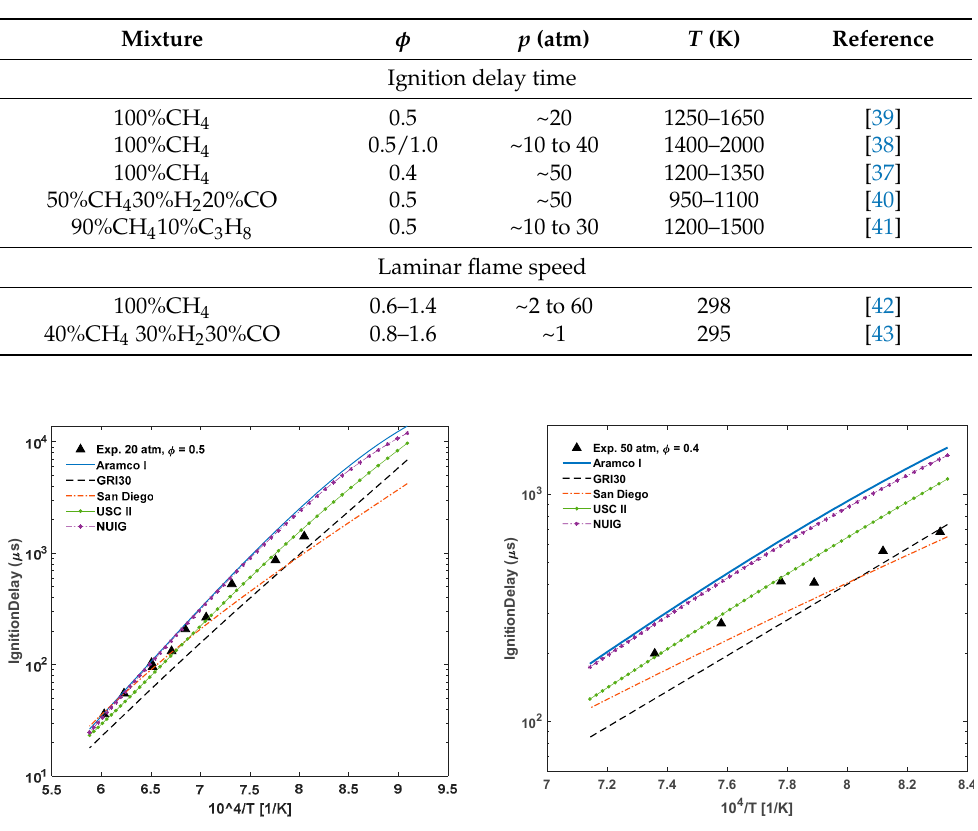
Figure 1. Comparison of methane ignition delay time for different mechanisms with the experimental data: left : p = 20 atm and φ = 0.5 [44]; right : p = 50 atm and φ = 0.4